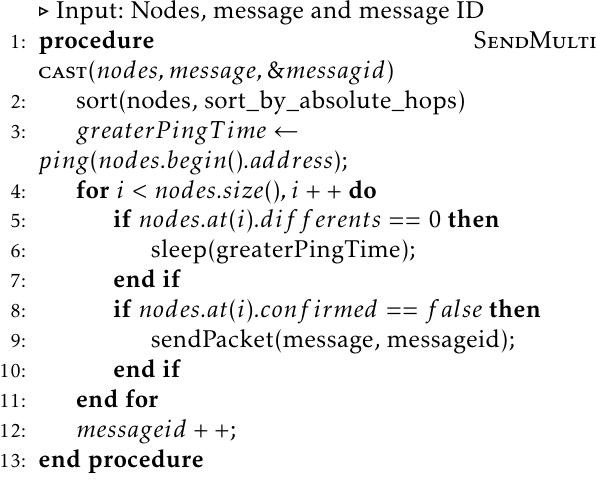
Algorithm 2 The multicast algorithm on the gateway.